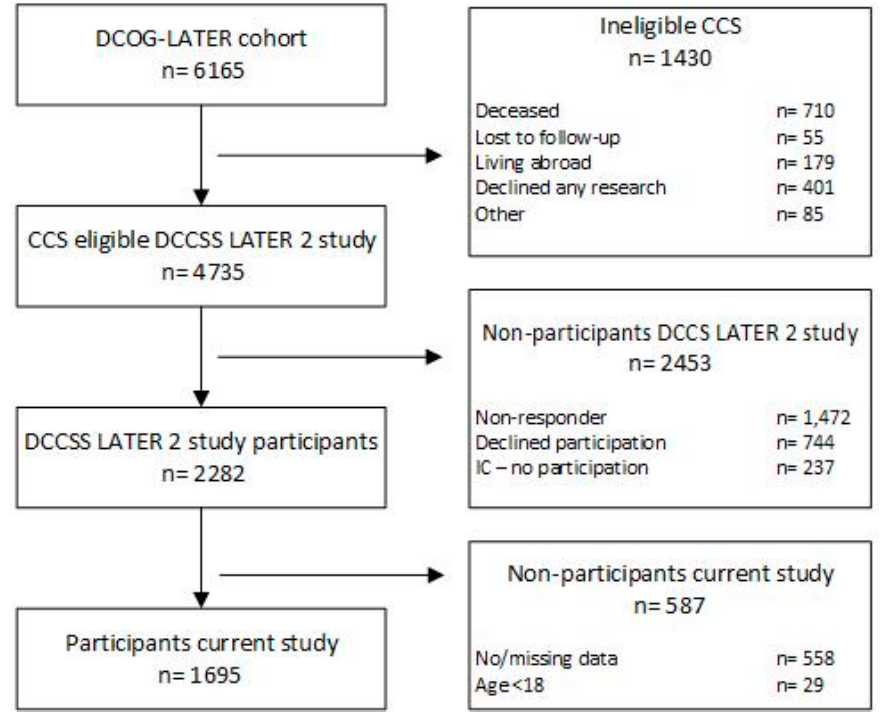
Figure 1. Flowchart of CCS participants. IC—no participation: Did return informed consent wanting to participate but did not participate (due to logistic reasons or lack of time for example). No/missing data: no or incomplete data for the CIS fatigue severity subscale, duration of fatigue symptoms or all of the HRQOL